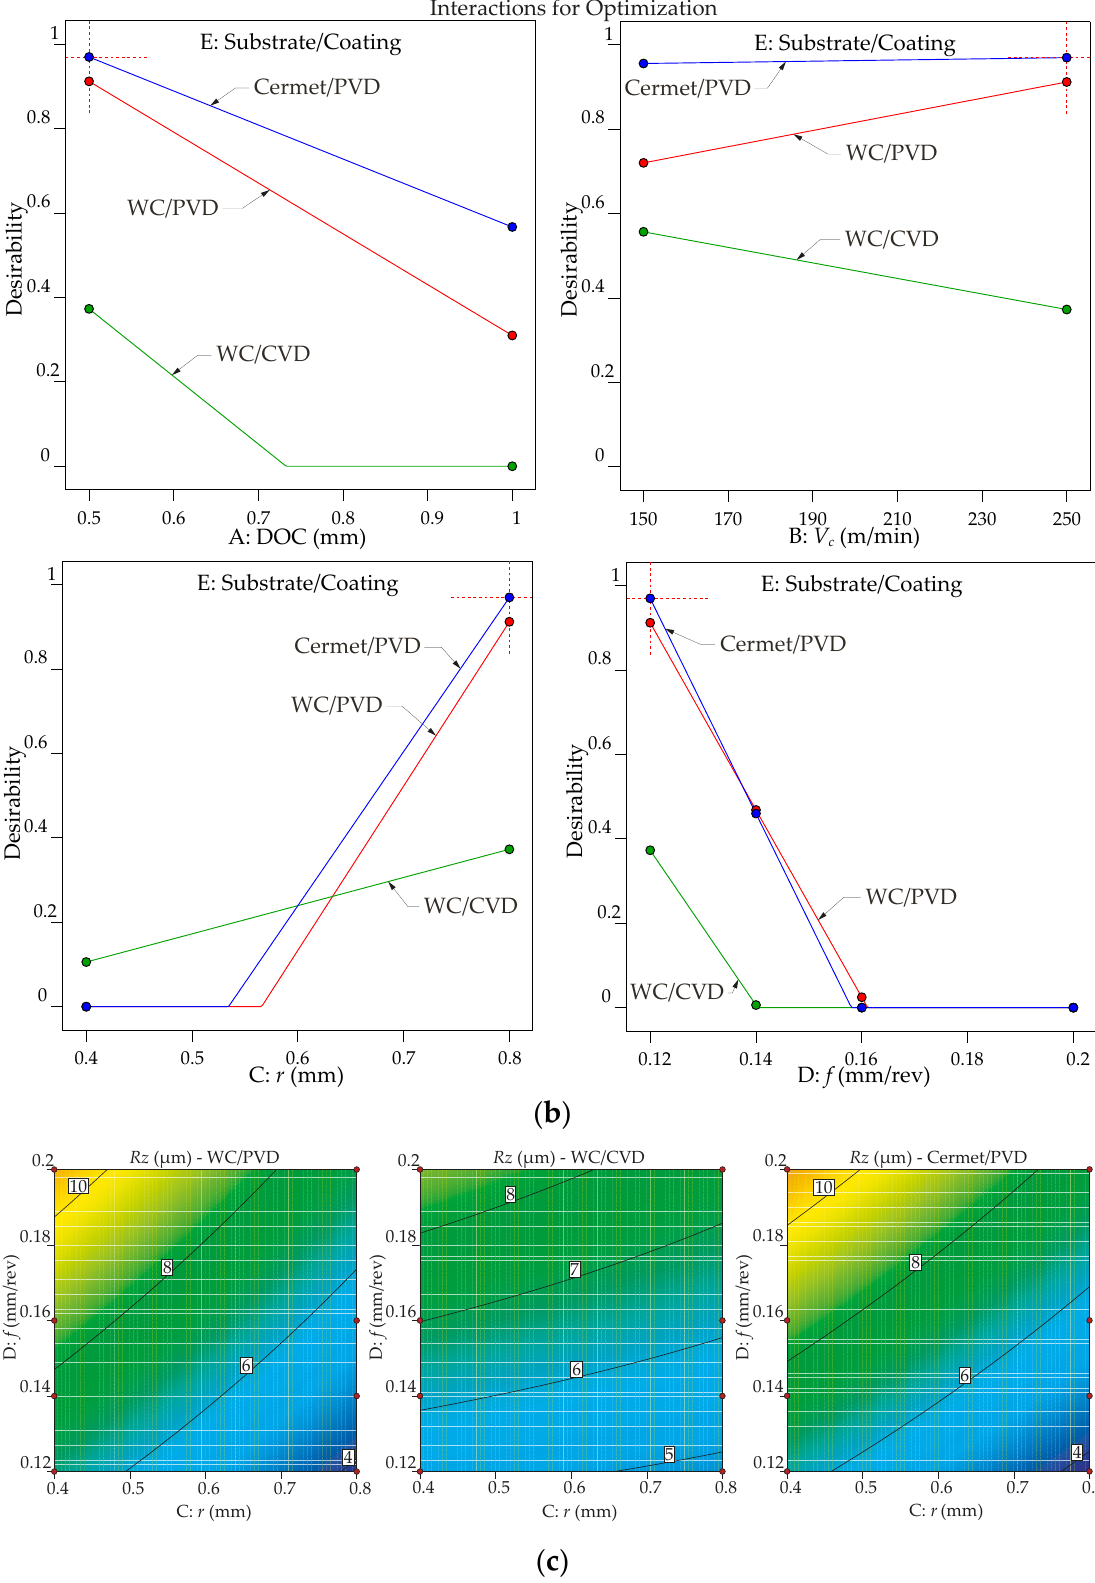
Figure 14. Graphs of optimization results to minimize Rz as a goal: ( a ) effect of cutting tool types; ( b ) interaction effects of DOC*Substrate/Coating, V c *Substrate/Coating, Substrate/Coating* r and Substrate/Coating* f ; ( c ) Rz contour levels versus nose radius and feed rate.